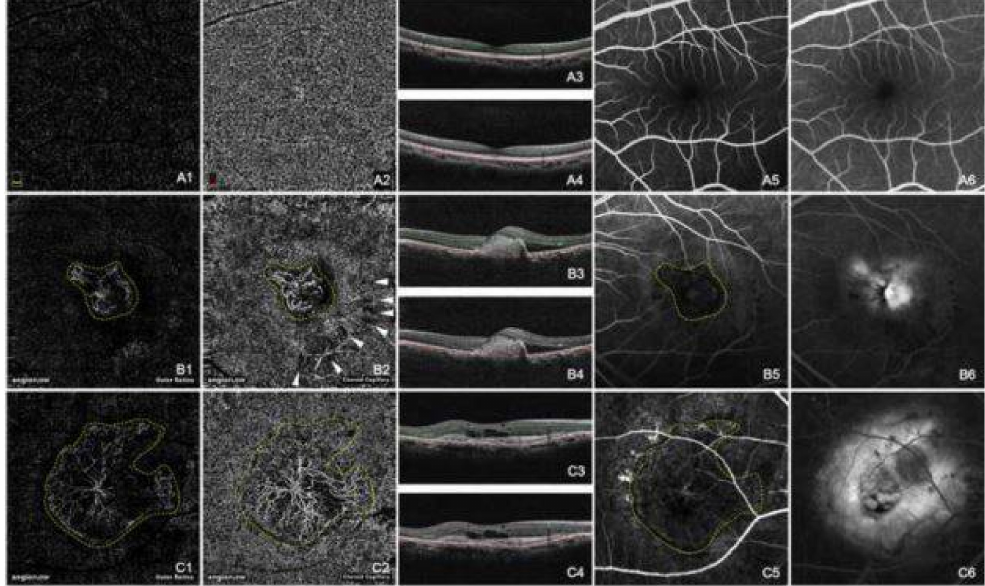
Figure 1. Normal choroidal vasculature (A) and CNV (B and C) demonstrated by OCTA and FA. The normal appearance of the outer retina shows an absence of blood flow ( A1 ). The normal appearance of the choroid shows homogeneous grayish capillary beds ( A2 ). The early phase and the late phase of normal FA images were shown in ( A5 ) and ( A6 ) respectively. Hyperreflective CNVs were demonstrated at both the outer retina level ( B1 , C1 ) and the choroid capillary level ( B2 , C2 ). The configurations of these CNV lesions were strikingly identical with those in the early phase of FA ( B5 , C5 ). CNV was in a globular aspect in ( B1 , B2 ), while in a fan-like shape with a feeder vessel in ( C1 , C2 ). The hyporeflective speckles (white arrowheads, B2 ) regarding the hard exudates were “mirror images” projected from the deep retinal plexus layer (not shown). The early phase of FA ( B5 , C5 ) revealed hyperfluorescent CNVs, while the late phase of FA ( B6 , C6 ) showed leakage and edema caused by CNV. The double lines in B scan OCT images of A3 , A4 , B3 , B4 , C3 , and C4 indicated the layers exhibited in A1 , A2 , B1 , B2 , C1 , and C2 respectively. (Yellow dashed line: CNV; White arrow head: “mirror image” of hard exudate)